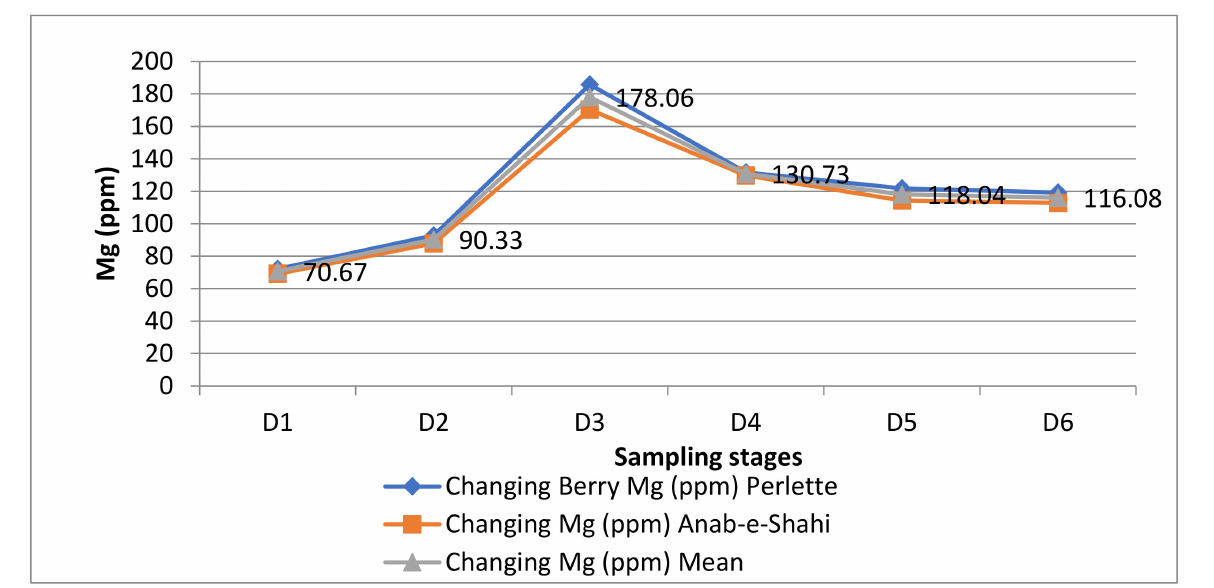
Figure 5. Dynamics of Magnesium (ppm) during the development of berries in grapes cv. Perlette and Anab-e-Shahi.